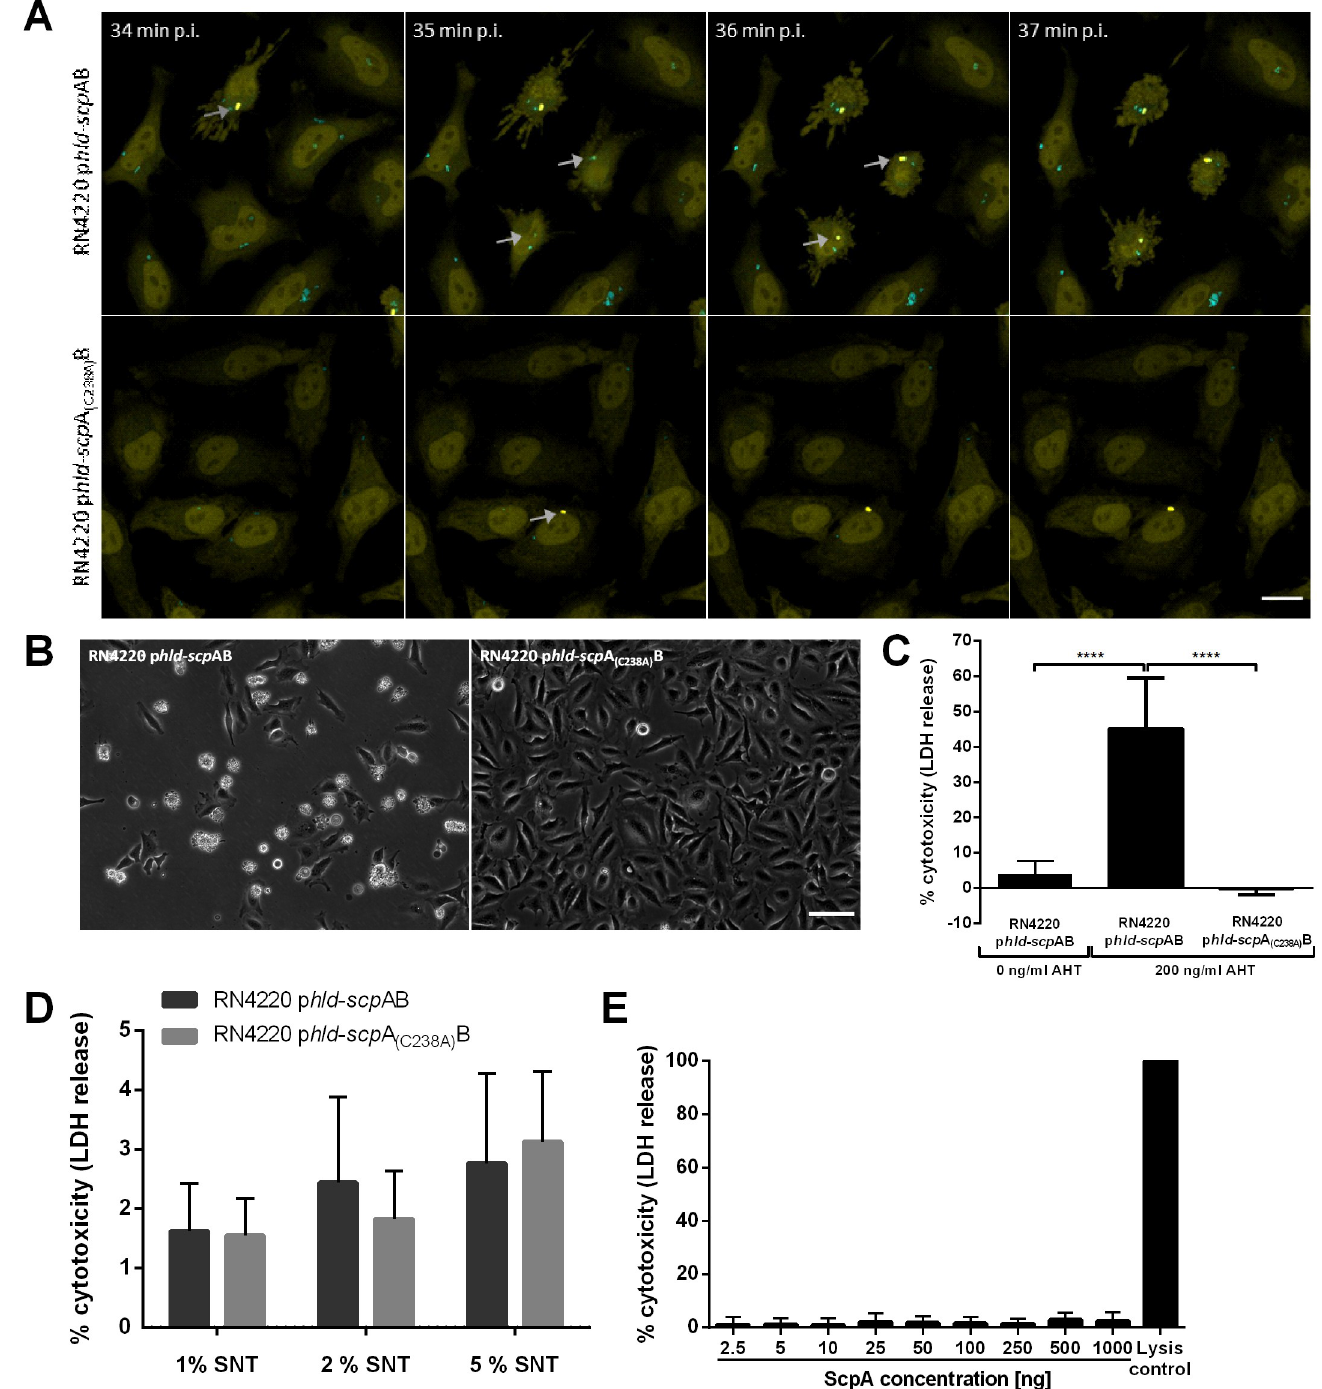
Fig 5. Ectopic expression of staphopain A in a non-cytotoxic S . aureus strain induces host cell death after phagosomal escape. (A) HeLa YFP-CWT cells were infected with S . aureus RN4220 p hld - scp AB (upper panel) or RN4220 p hld - scp A (C238A) B (lower panel). Live cell imaging displayed phagosomal escape (see arrows), upon which cell contraction only occurred, when a functional staphopain A was expressed (cyan: S . aureus , yellow: YFP-CWT, scale bar: 20 μ m). (B) Phase contrast images of infected HeLa cells at 2 h p.i. to reveal different morphologies of cells infected with RN4220 p hld - scp AB compared to RN4220 p hld - scp A (C238A) B (scale bar: 100 μ m). (C) LDH release of HeLa cells was quantified 6 h after infection with S . aureus RN4220 p hld - scp ABor RN4220 p hld - scp A (C238A) B. If indicated, 200 ng/ ml AHT was added 1 h prior to infection. Overexpression of functional ScpA resulted in increased plasma membrane damage (n = 6). (D) HeLa cells were treated with 1, 2 or 5% of sterile culture supernatant (SNT) of S . aureus RN4220 p hld - scp AB or RN4220 p hld - scp A (C238A) B and 24 h after treatment LDH release was